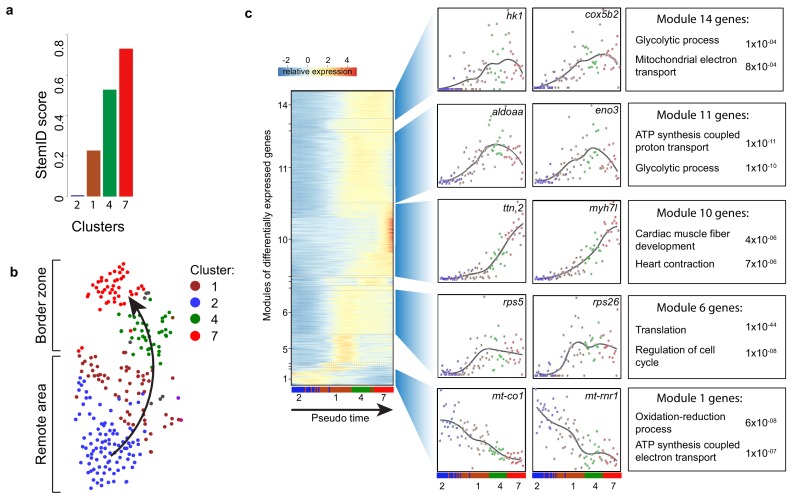
Pseudo time analysis reveals dedifferentiation and metabolic changes in border zone cardiomyocytes.(a) Bar plot of StemID scores for the cardiomyocyte clusters (clusters #2, 1, 4 and 7) calculated by the formula: number of significant links for each cluster multiplied by the median transcriptome entropy across all cells in a cluster. (b) Cardiomyocyte clusters from adult injured heart. Arrow indicates the dedifferentiation path derived from the StemID scores. (c) Pseudo time analysis. Left; one-dimensional SOM of z-score transformed expression profiles along the differentiation trajectory incurred by StemID analysis. Y-axis represents the fourteen modules with differentially expressed genes. X-axis represents the pseudo time in which the cells were ordered. Middle; expression profiles of representative genes of the major modules. Y-axis shows transcript counts. X-axis represents the pseudo time. Right; Major gene ontology terms derived from all genes expressed in the module with p-values.Figure 3—source data 1.List of genes that are differentially upregulated in the respective modules identified in the pseudo timeline analysis (related to Figure 3c).